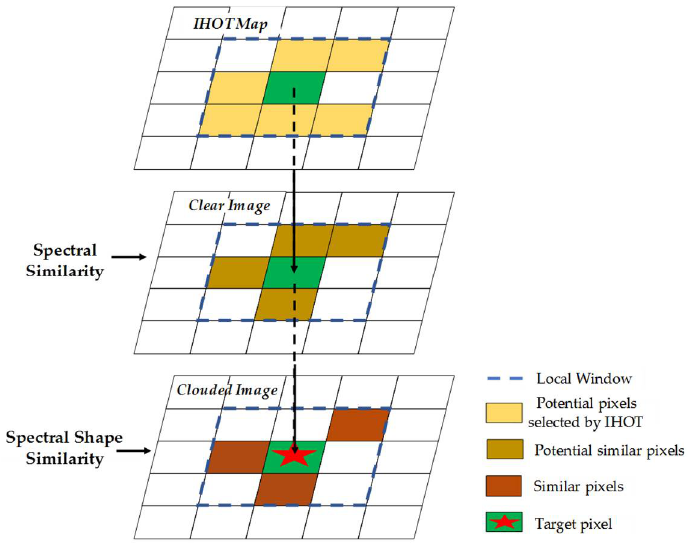
Figure 4. Illustration of the process searching for similar pixels.